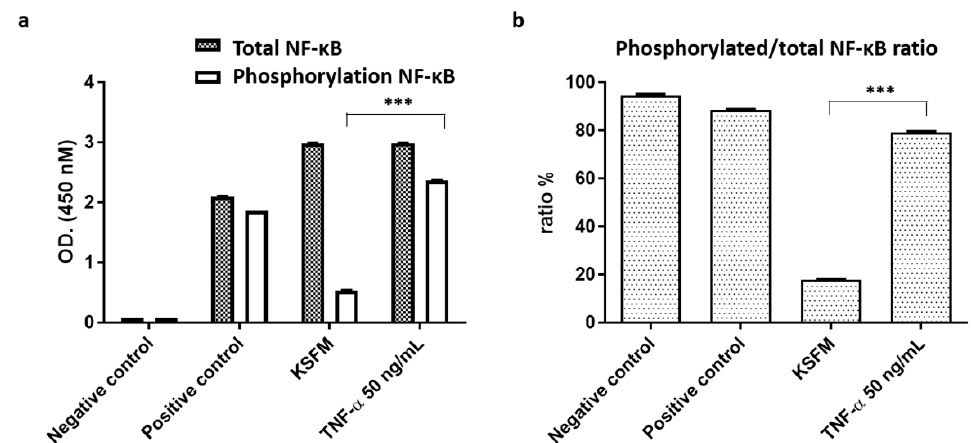
Figure 3. Nuclear factor (NF)- κ B expression in ADSCs treated with tumor necrosis factor (TNF)- α . ( a ) Quantification of total and phosphorylation of NF- κ B, respectively. ( b ) Quantification of phosphorylated/total NF- κ B ratio (OD = optical density, KSFM = keratinocyte serum-free medium, *** p < 0.001).